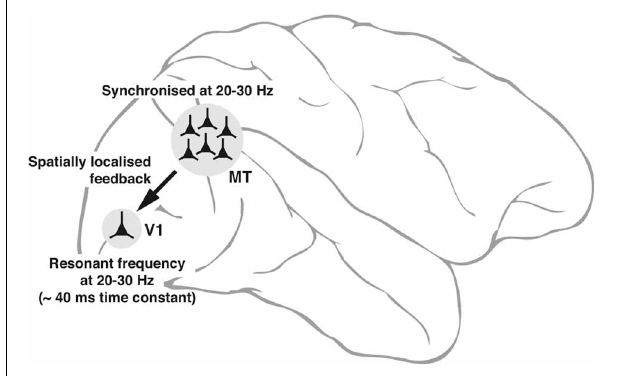
FIGURE 3 | Schematic diagram, explaining the neuronal basis of feedback oscillations. Local network properties and biophysical parameters such as time constants of neurons determine the synchronizing frequencies of neurons in MT that provide feedback to V1 and the resonant properties of neurons in V1. It is suggested that a group of neurons representing a single location (of say, an object) in the parietal saliency map sending its signals via the corresponding group of neurons in MT can set the membrane potential of the spatially equivalent group of neurons in V1 (only 1 shown) to oscillate at its resonant frequency. Such an oscillation would facilitate the V1 neurons to respond to a sensory input more readily as the input signals ride on the top of the depolarizing crests in membrane